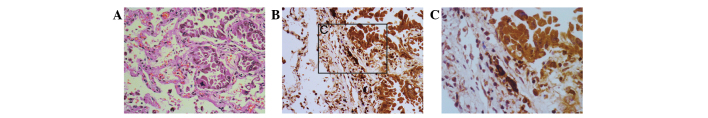
Girdin is present in human lung cancer tissues. (A) Human lung cancer and distal normal tissues were identified by hematoxylin and eosin staining. (B) Protein expression of Girdin was mainly evident in the cytoplasm with yellow or brown-yellow staining. The cancer tissues were strongly stained by anti-Girdin antibody, but staining was less prominent in the distal normal lung tissue. (C) Magnified image of box in B. Magnification, ×200 (A and B) and ×400 (C).